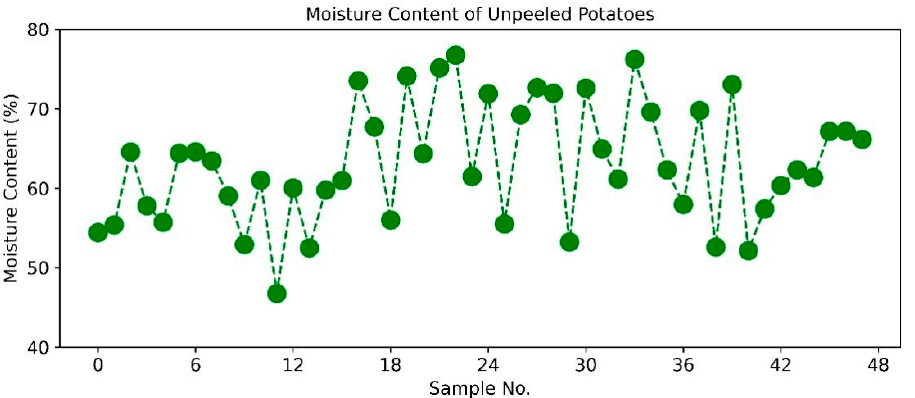
Figure 2. Moisture content of unpeeled